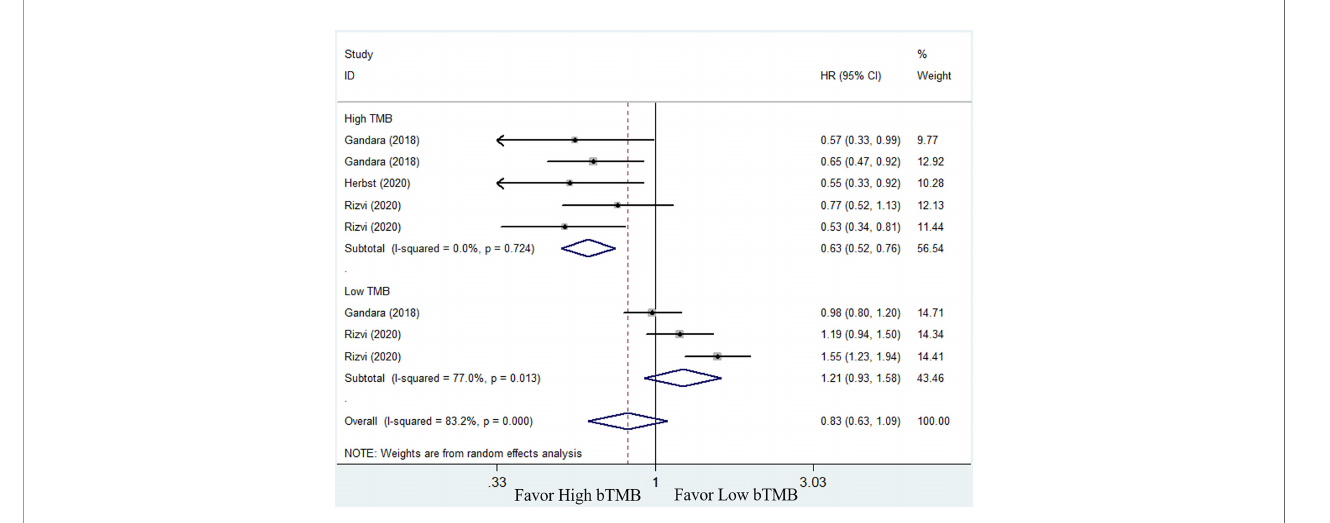
FIGURE 5 | Forest plot of ef fi cacy comparison of ICIs to chemotherapy for progression-free survival (PFS) and subgroup analysis.